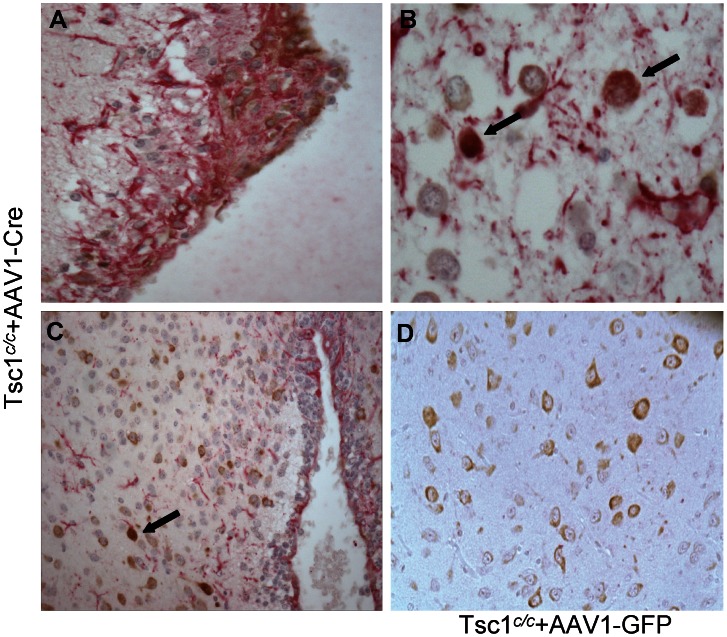
pS6 and GFAP double immunostaining to assess astrocyte transduction.
Tsc1c/cROSA homozygous pups were injected ICV at P0 with either an AAV1-CBA-GFP or AAV1-CBA-Cre vector at a concentration of 2×1010g.c. One month later two of the pups injected with AAV1-CBA-Cre virus who developed distress were sacrificed and showed severe hydrocephalus by neuropathological examination. To assess astrocyte transduction, the brains were double stained for pS6 and GFAP and counter stained with haematoxylin. Intermediate or mixed cells which stain for both the markers were seen in the (A) periventricular region and (B) subependymal lining. No co-localization was seen in the cortex except for a very few cells(C). No double staining was seen in any region of the brain in AAV1-GFP injected brain (D). Arrows indicate double stained cells. Magnification = 40X.